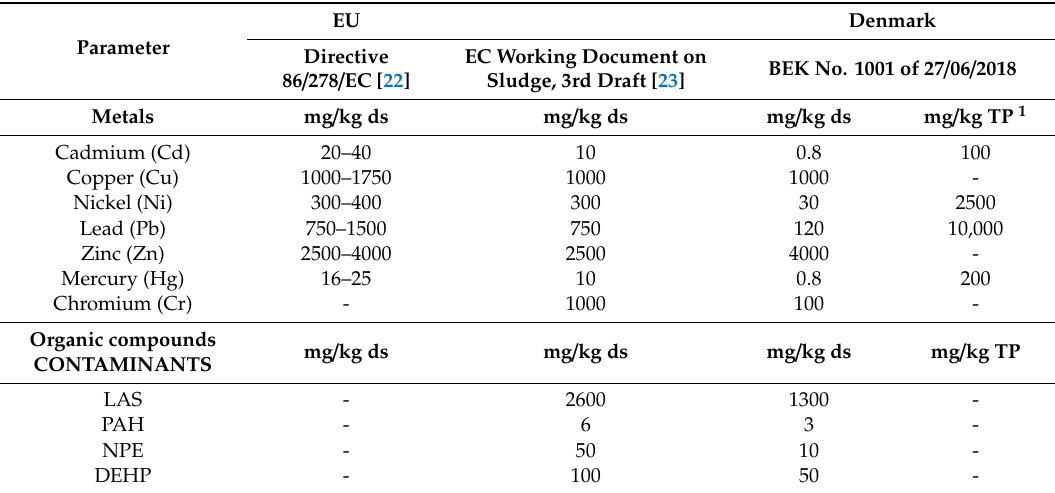
Table 1. Regulatory limits in Denmark and the European Union (EU) for heavy metal and hazardous organic compound contents in sludge reused in agriculture